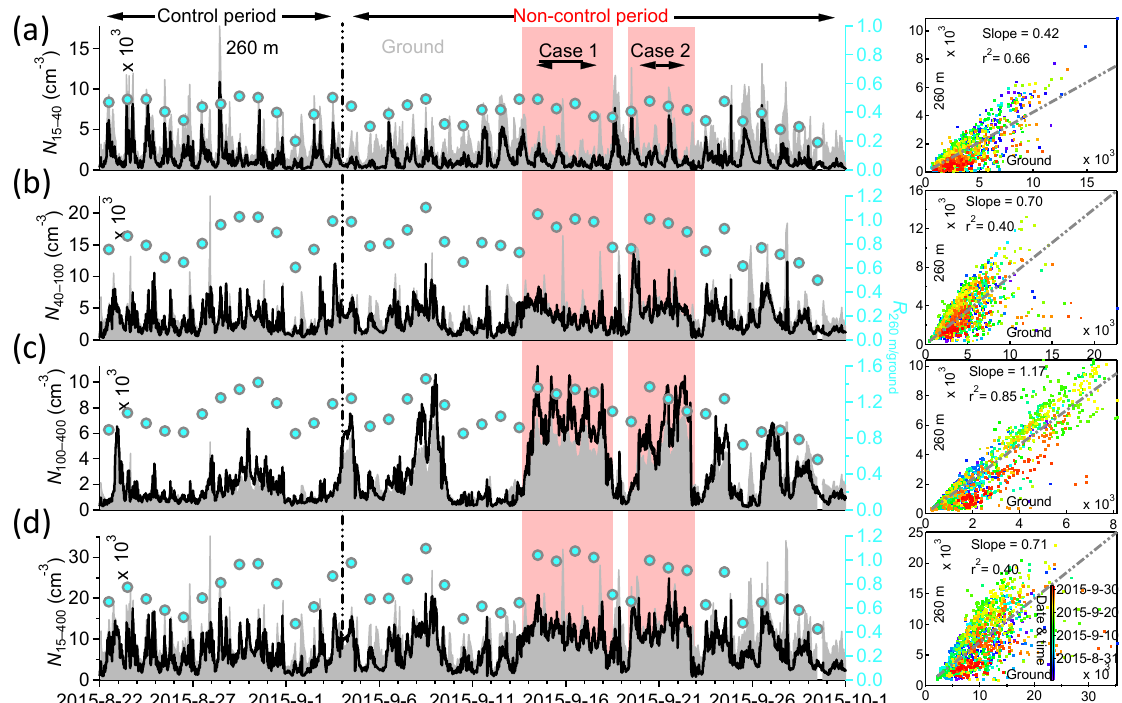
Figure 2. Comparisons of particle number concentrations between ground level and 260m for different size ranges, i.e., (a) small Aitken mode (15–40nm), (b) large Aitken mode (40–100nm), (c) accumulation mode (100–400nm), and (d) the total number of particles (15– 400nm). The right-hand panels show the scatter plots of the